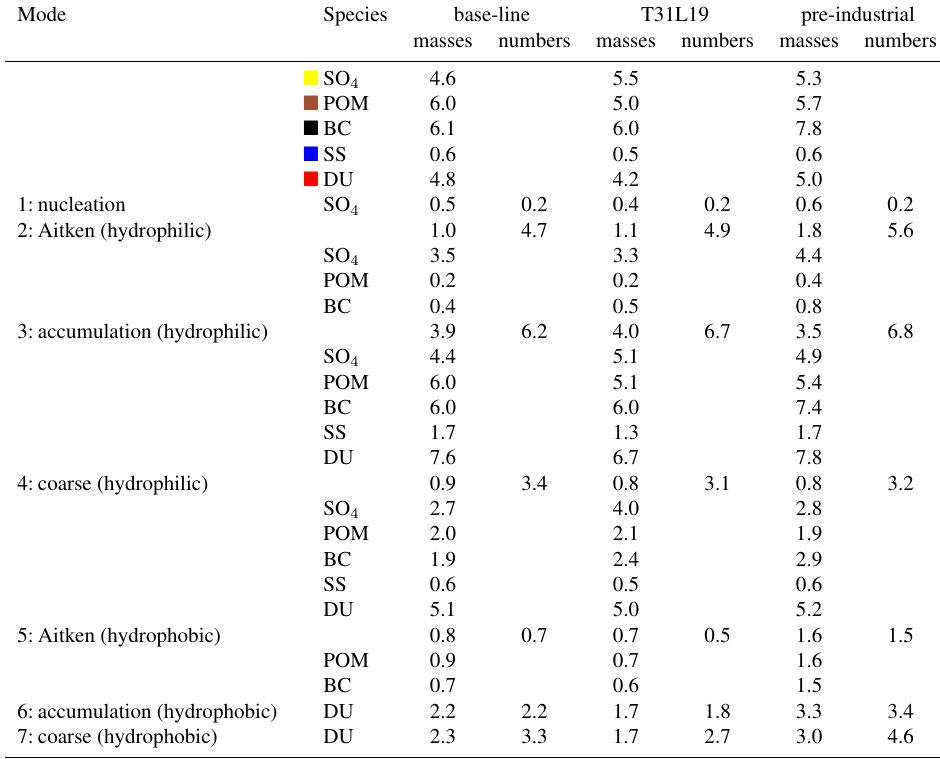
Table 3. Life-times [days] of all modes and species in ECHAM5.5-HAM2 Table 3. Lifetimes [days] of all modes and species in ECHAM5.5-HAM2.